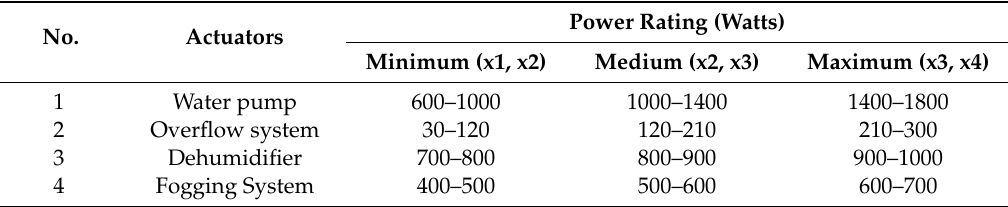
Table 2. Power consumption ratings of actuators’ working